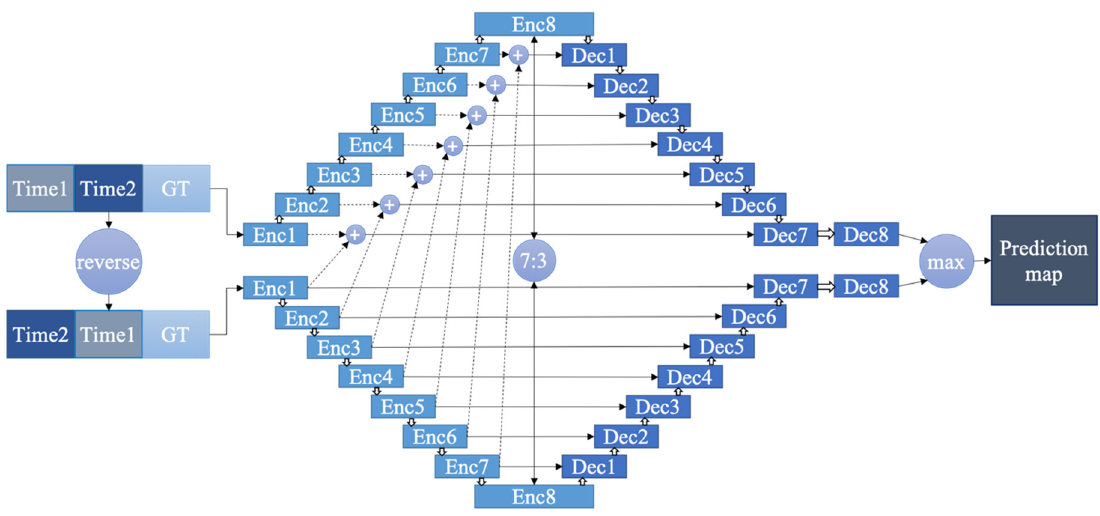
Figure 1. Architecture of the Chronological Order Reverse Network (CORN).